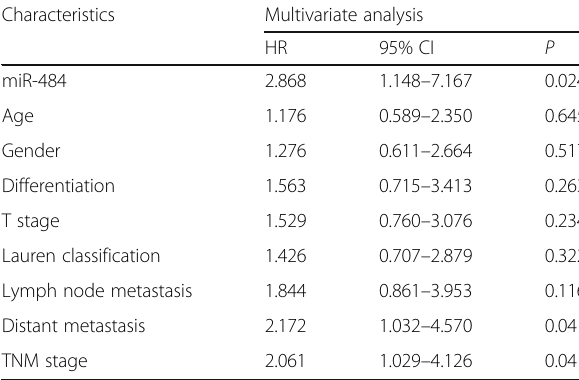
Table 2 Multivariate Cox analysis of clinical parameters